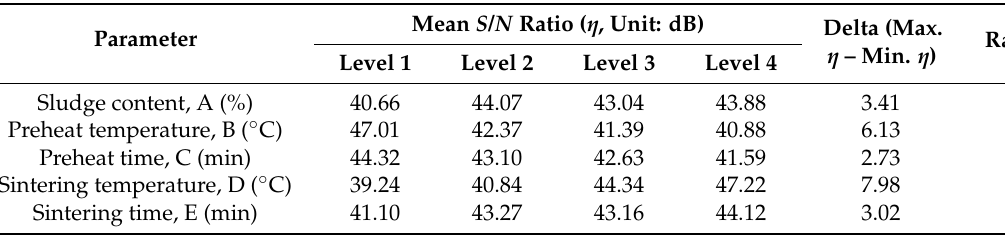
Table 10. S / N response table for bloating ratio.